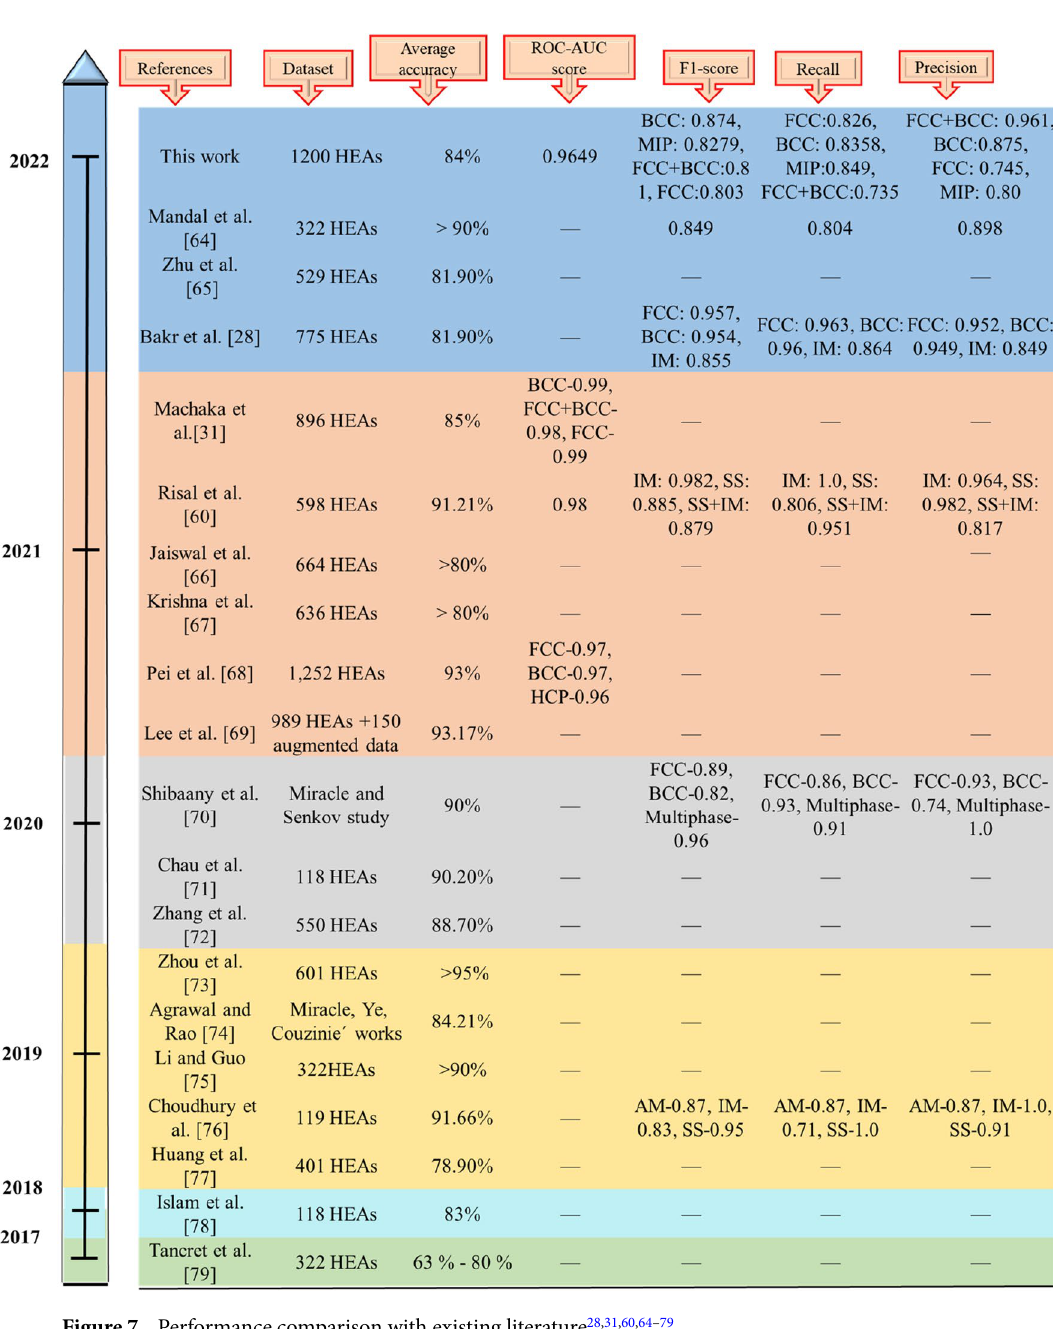
Figure 7. Performance comparison with existing literature 28,31,60,64–79 .